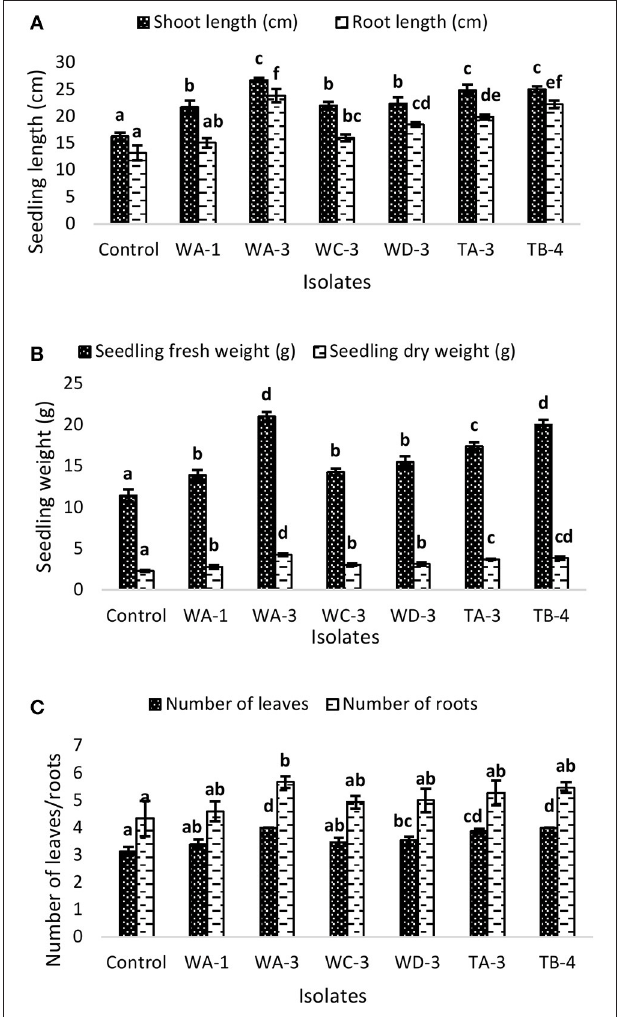
FIGURE 5 | Effect of seed treatment with actinomycetes spore suspensions on plant growth promotion of Triticum aestivum . (A) Seedling root and shoot length (cm) (B), seedling fresh and dry weight (g) (C) number of leaves and roots per plant. Evaluation was made 30 days after planting. Bars represents mean ± SE of three replicates (15 plants). Different letters on bars indicate significant difference between treatments, using Duncan’s multiple range test ( P = 0.05).